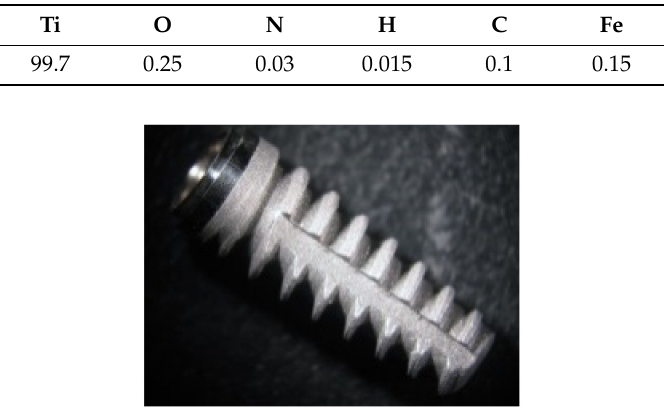
Figure 7. A picture of the dental implant covered by TiO 2 nanotubes [37].